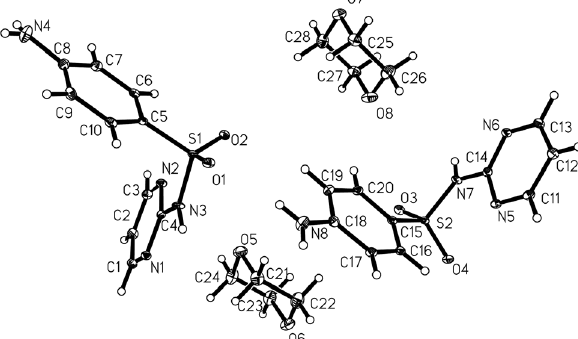
Table  : Data collection and